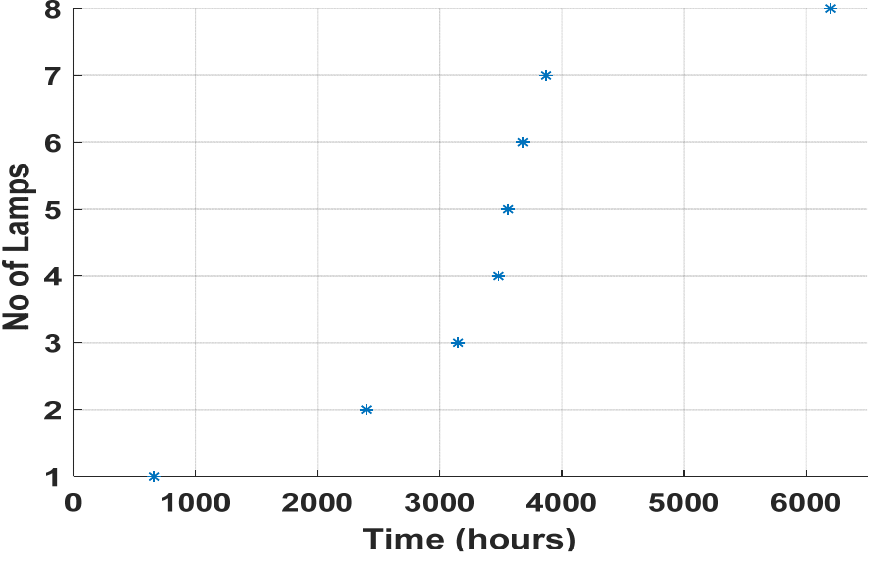
Figure 6. Times at which the lamps